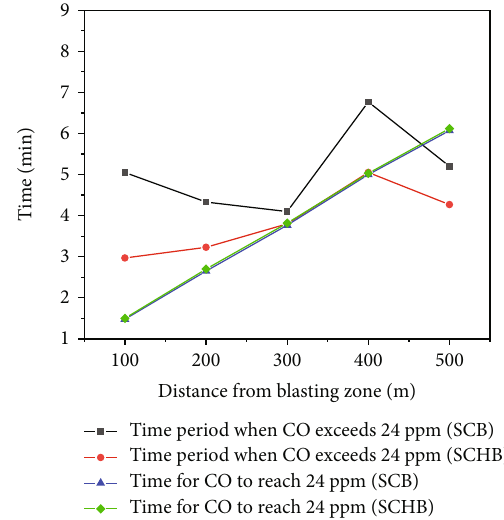
Figure 23: Time taken by CO to reach 24 ppm and exceed the same with the monitoring distance in six-hole SCB and